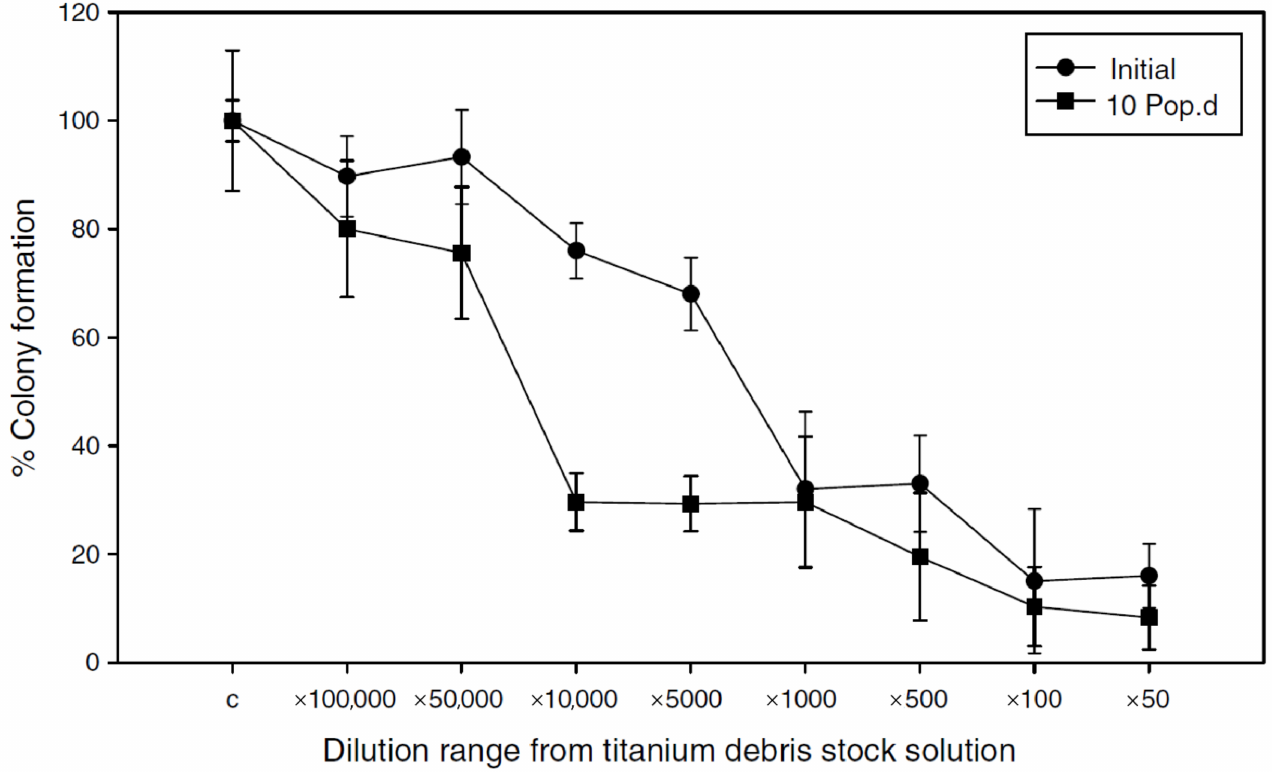
Figure 5. The initial curve represents the percentage survival of colony formation of HF19 cells exposed to titanium particles for 24 h. The percentage of survival of the progeny of these cells is also shown, indicating delayed reproductive death 10 generations postexposure. All percentages are expressed relative to the control expressed as 100%. Reprinted with permission from